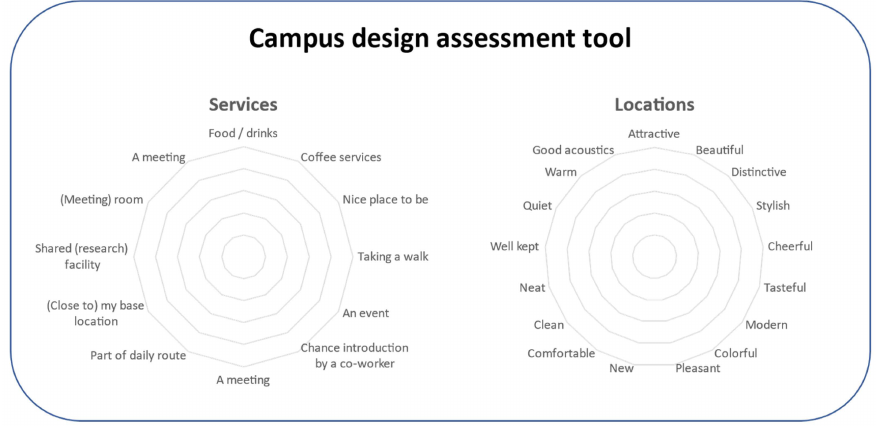
Figure 3. Campus design assessment